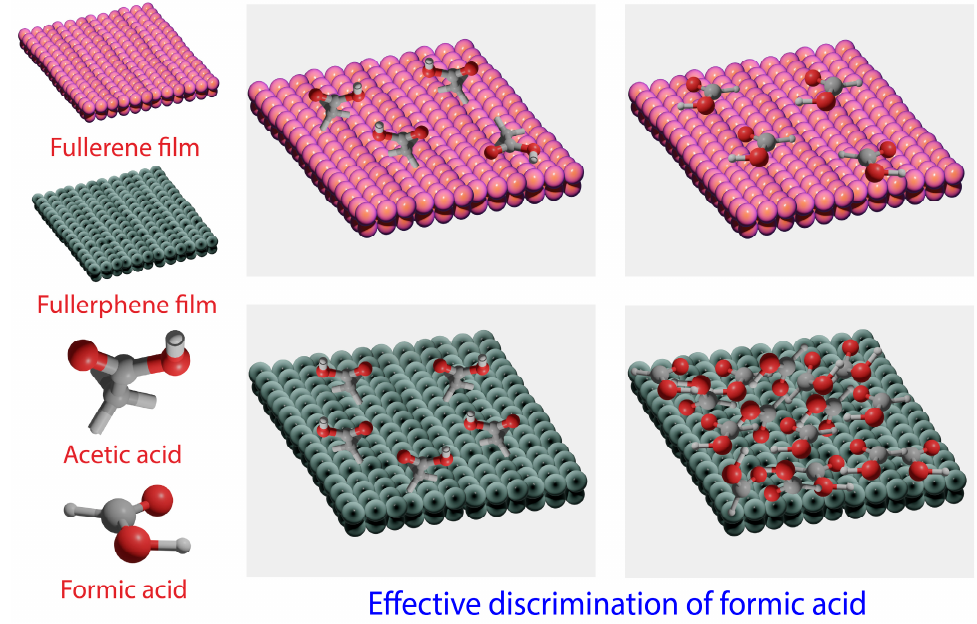
Figure 5. Atomic/molecular level molecular discrimination of formic acid by novel fullerphene